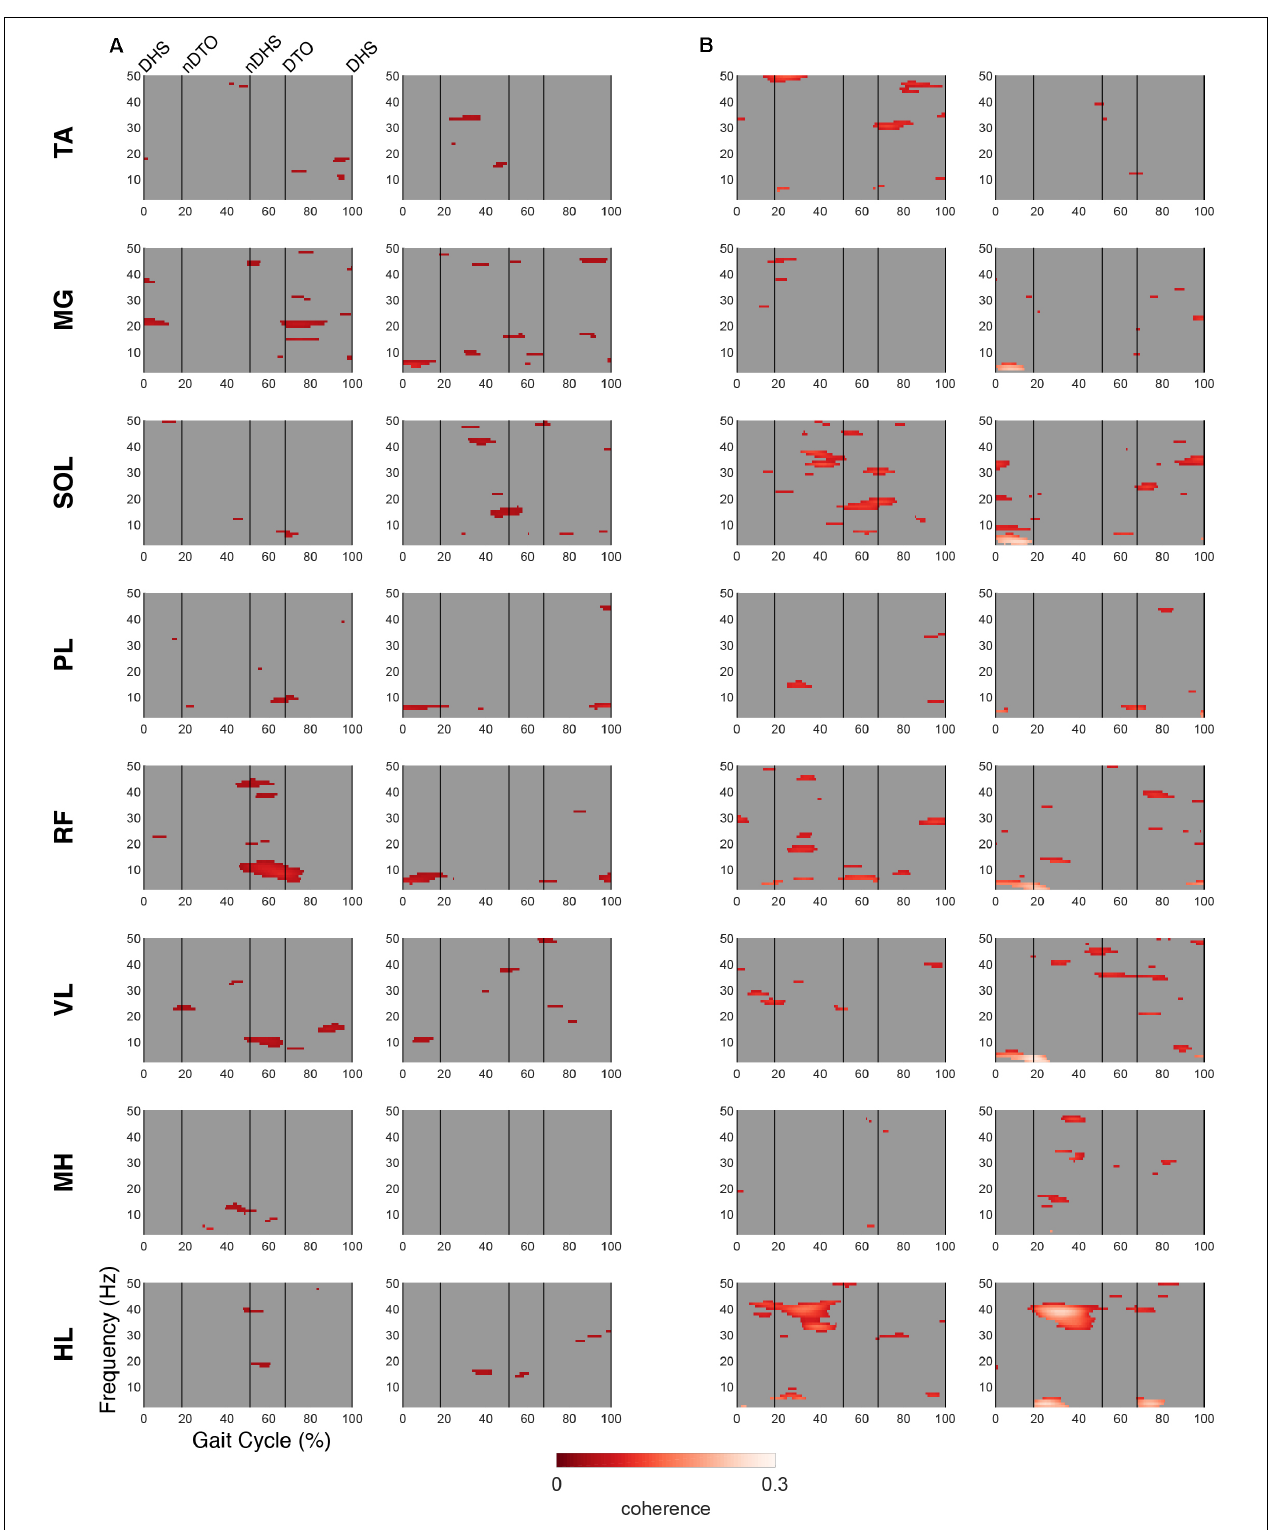
FIGURE 7 | EMG-IC coherence relative to non-dominant motor clusters. Linear coherence magnitudes between non-dominant (left)/dominant (right) EMG signals and non-dominant motor IC activations in (A) TD and (B) CP. Coherence plots were masked for significance (alpha < 0.05); non-significant values and time points where EMG signals led IC activations (phase > 0 radians) were set to 0 (gray).